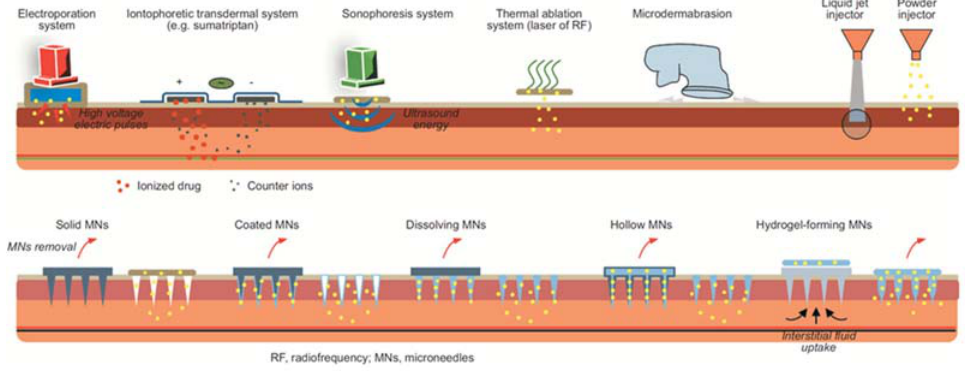
Figure 3. Physical methods for enhancement of percutaneous absorption [1]. Reprinted with permission from ref. [1]. Copyright 2019 Bentham Science.